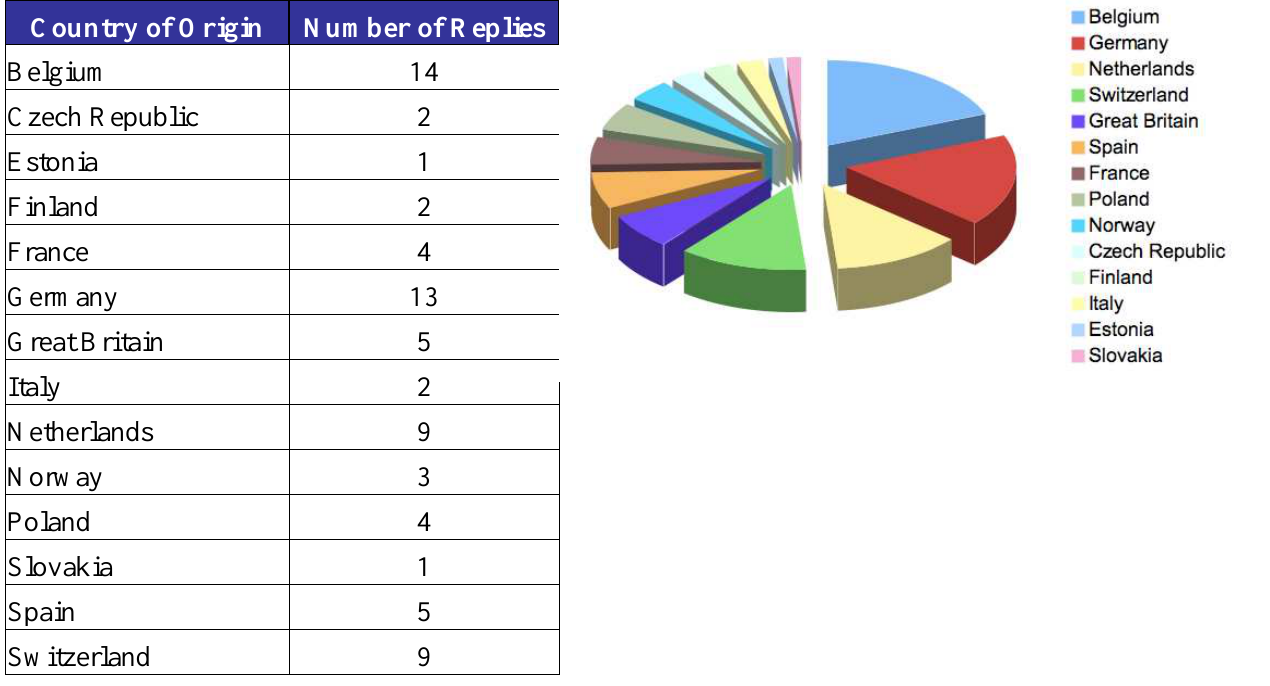
Figure 3. Researchers’ country of origin presented as table or as pie